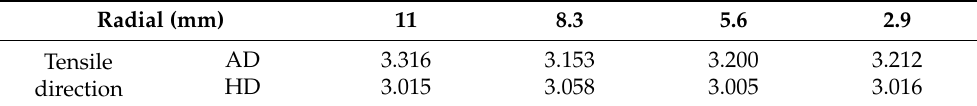
Figure 11. The Taylor factor distribution of the forged tube with a reduction of 42.7%: ( a – d ) tensile along AD; ( e – h ) tensile along HD. Table 7. The average Taylor factor of the forged tube with a reduction of 42.7%.